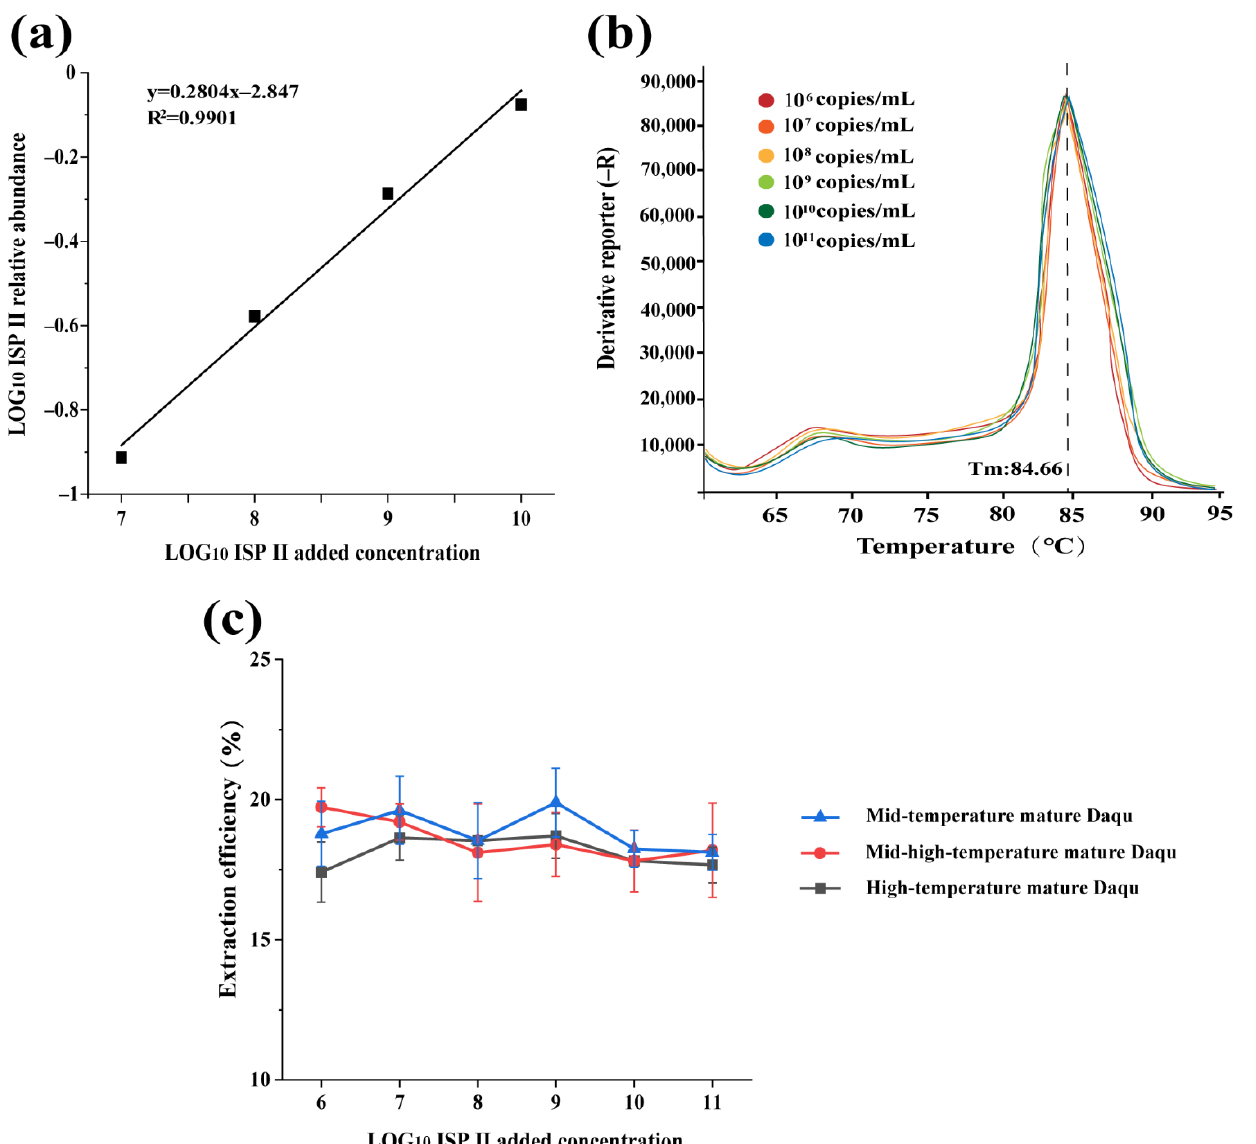
Figure 3. Verification of mixed ISP-added concentrations. ( a ) The regression equation of ISP II in high-temperature mature Daqu. ( b ) Melting curve of ISP II in high-temperature mature Daqu. ( c ) The extraction efficiency of ISP II in different mature Daqu.